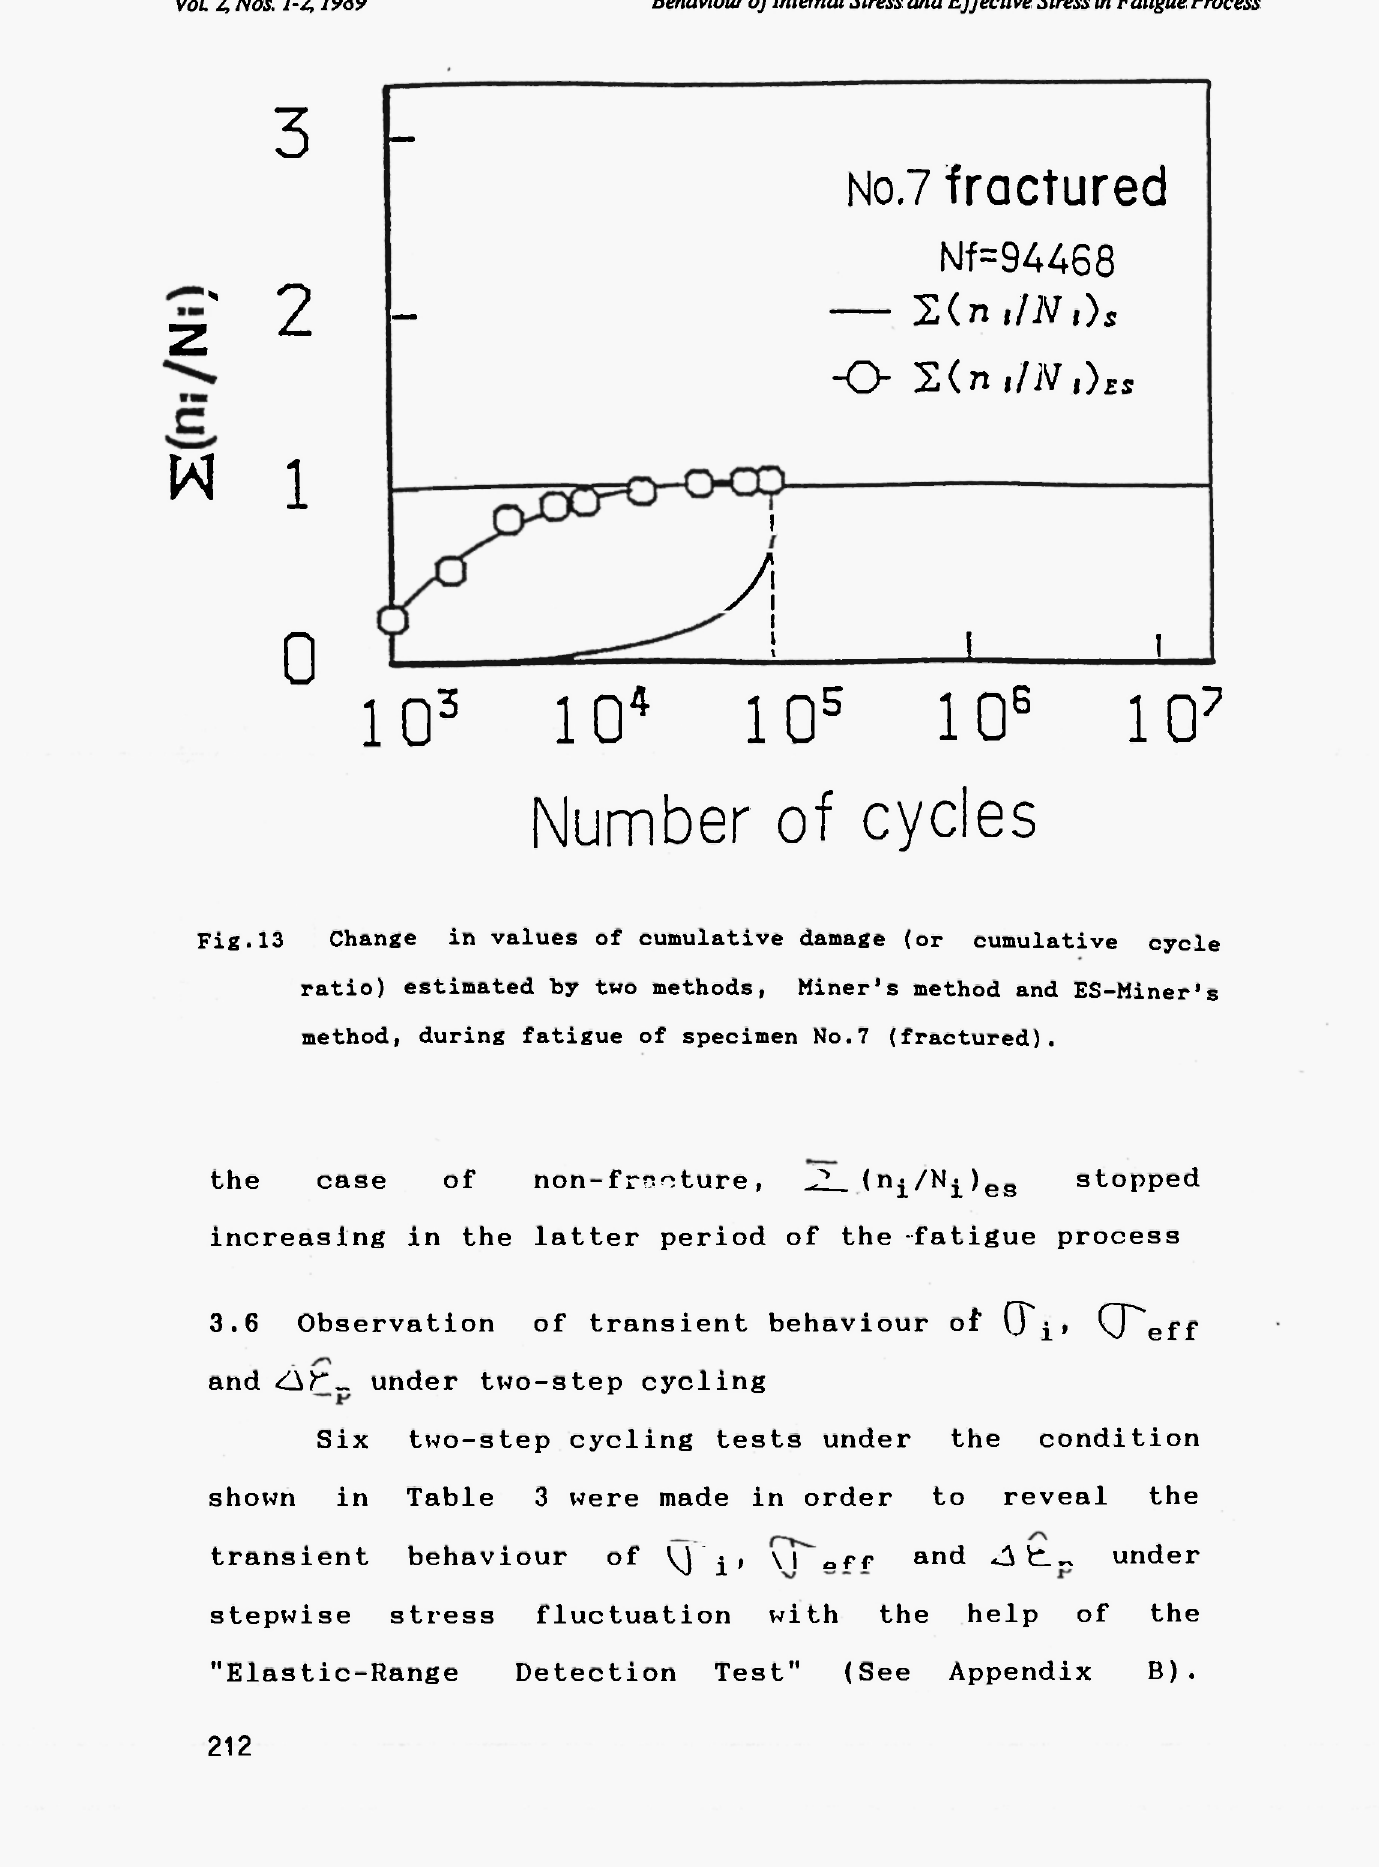
Fig.13 Change in values of cumulative damage (or cumulative cycle ratio) estimated by two methods, Miner's method and ES-Miner's method, during fatigue of specimen No.7